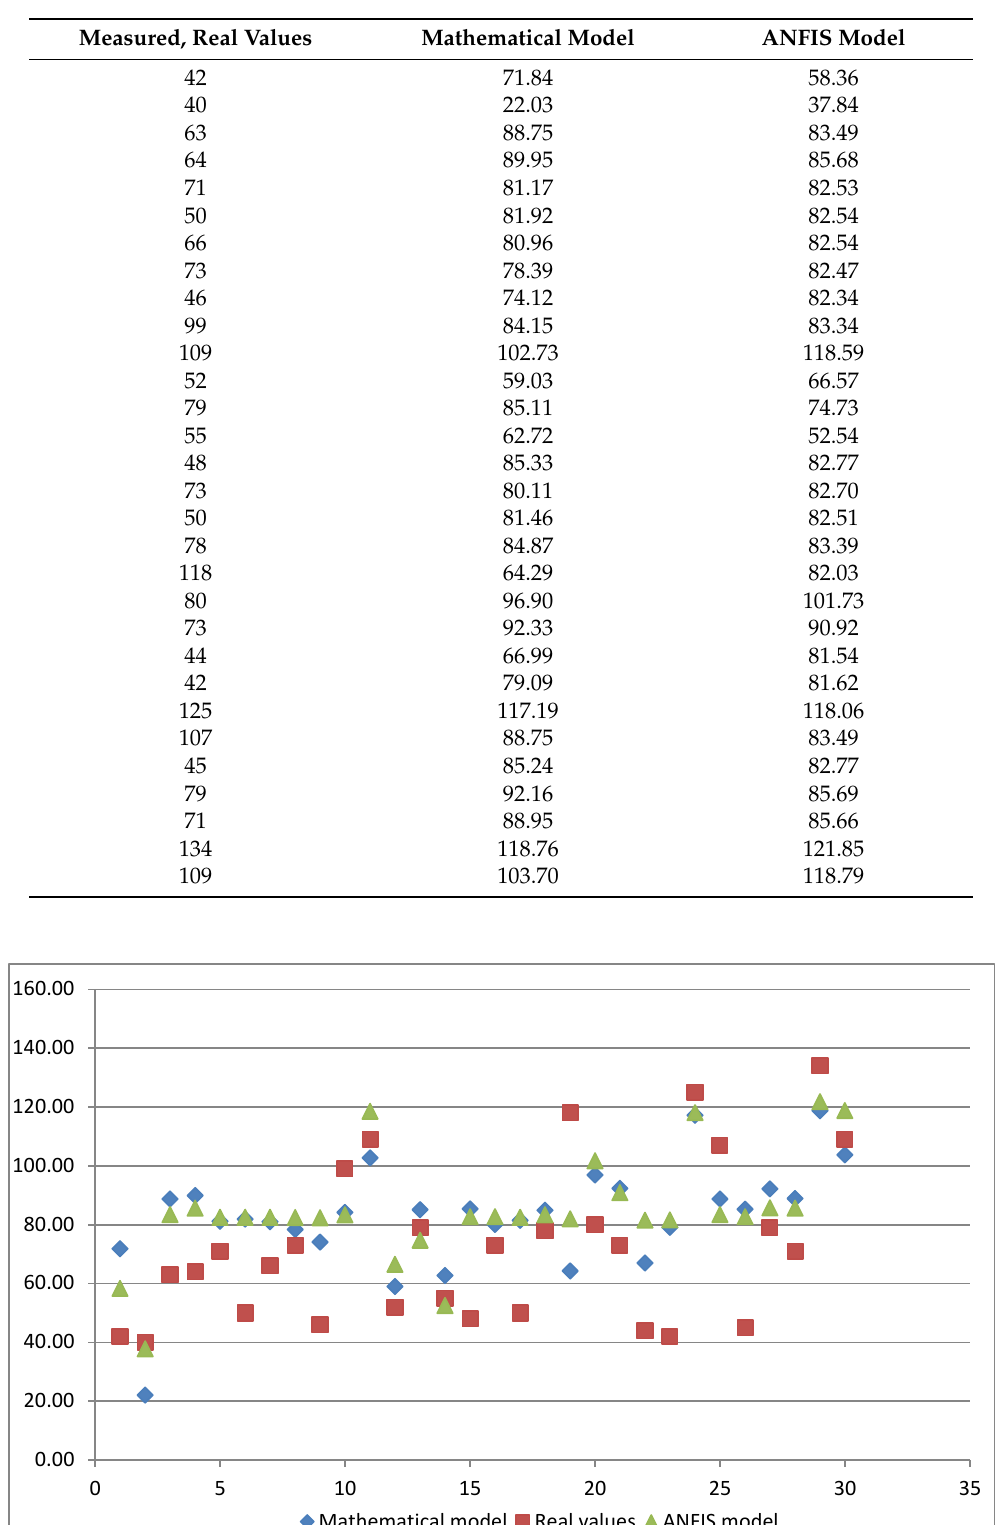
Table 8. Measured values of time in the system and predicted values determined by the mathematical and ANFIS model.